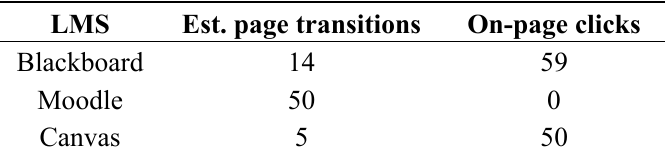
Table 1. Comparing Costs to Enter Data in Three LMS.